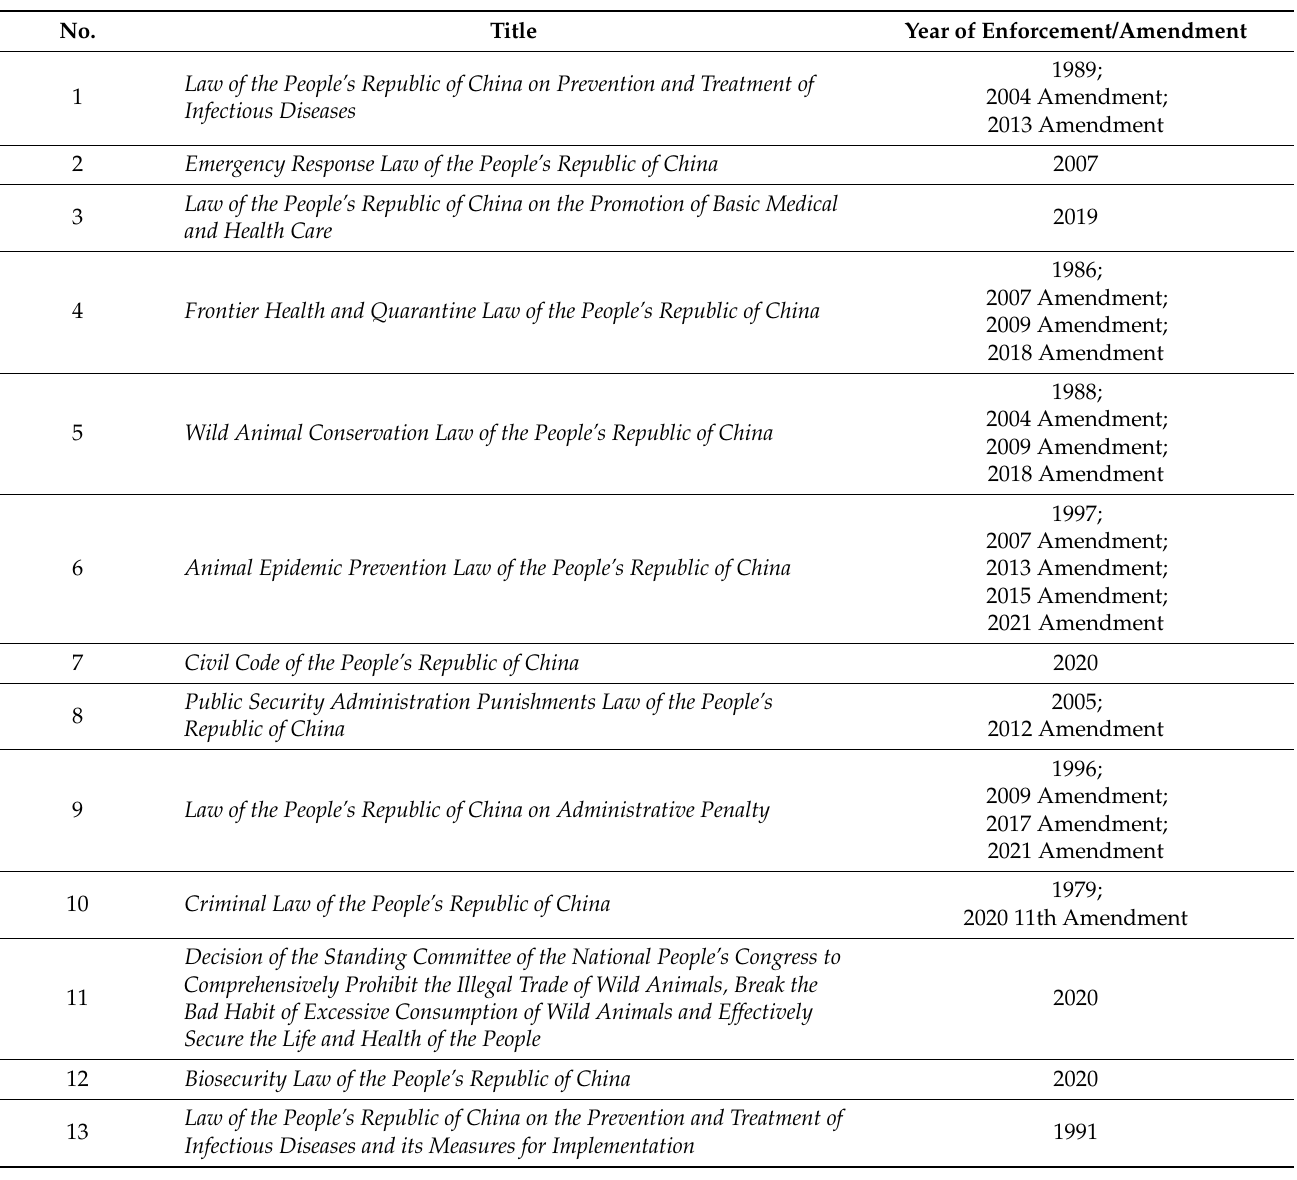
Table 2. Laws on Port Health Quarantine of PRC (International and Domestic laws/Regulations not